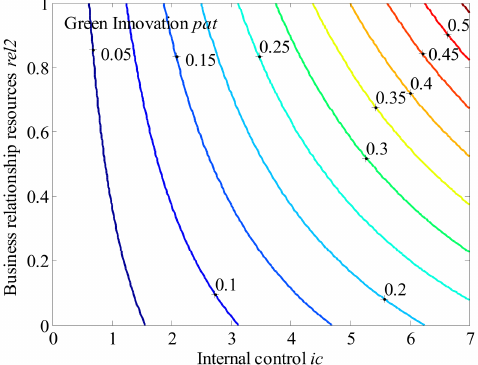
Figure 5. Regulatory effect of business relationship resources. Table 8. Heterogeneity test of relationship